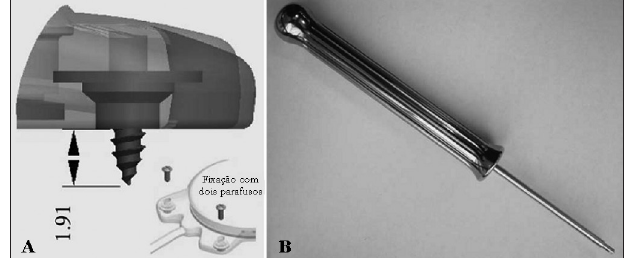
Figura 3. Ilustração do sistema de fixação do Digisonic ® SP com utili - zação de dois parafusos de titânio, que necessitam penetrar no osso temporal 1,91 mm. Não há necessidade de qualquer broqueamento ou preparo da região. Desenvolvido pela Neurelec